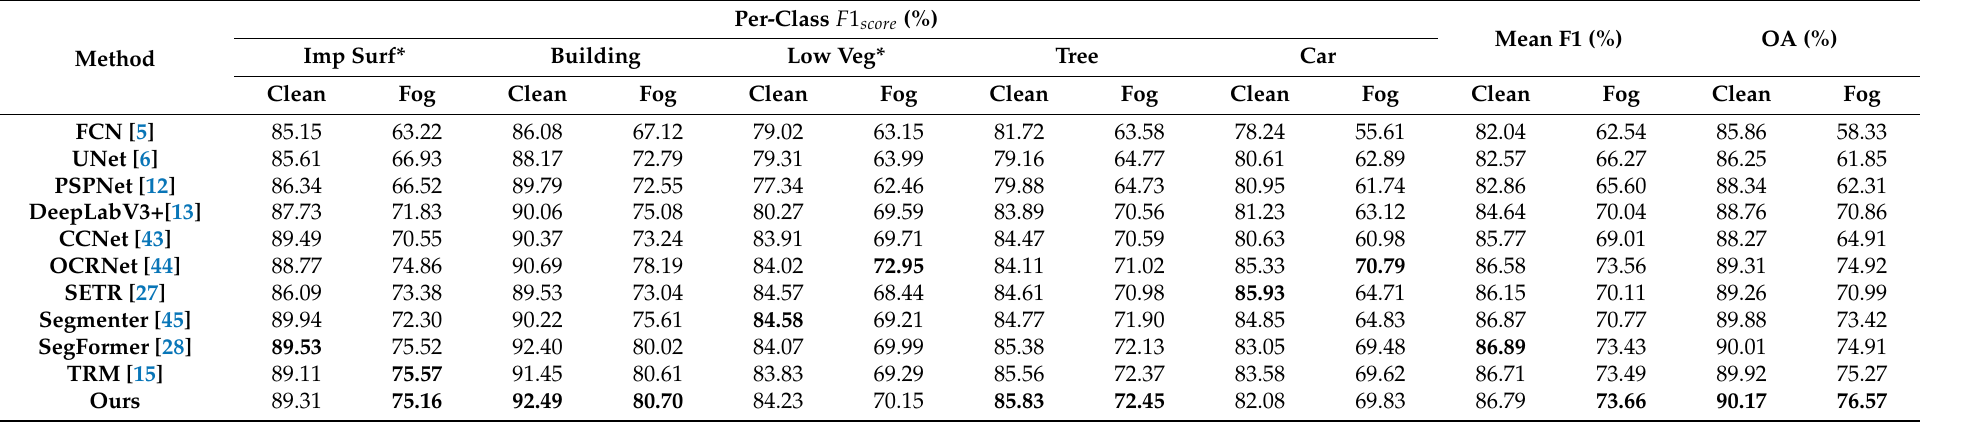
Table 8. Quantitative comparison with SOTA methods on the clean and fog corrupted variants of the Potsdam test set. Each F 1 score is averaged over all severity levels. The best results are marked in bold.